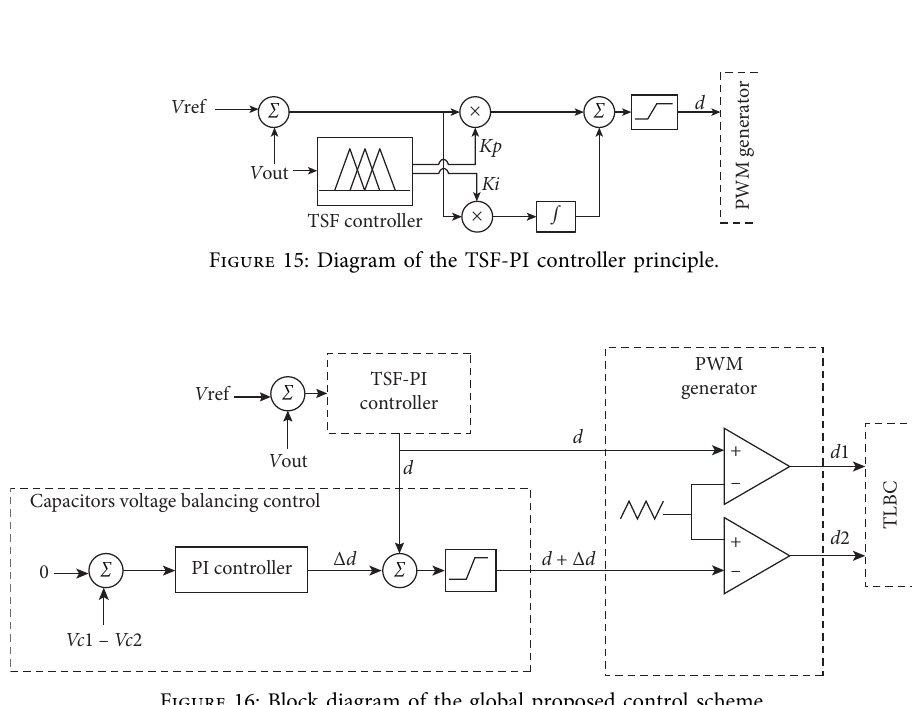
Figure 14: Fuzzy set membership functions of TSF-PI controller.